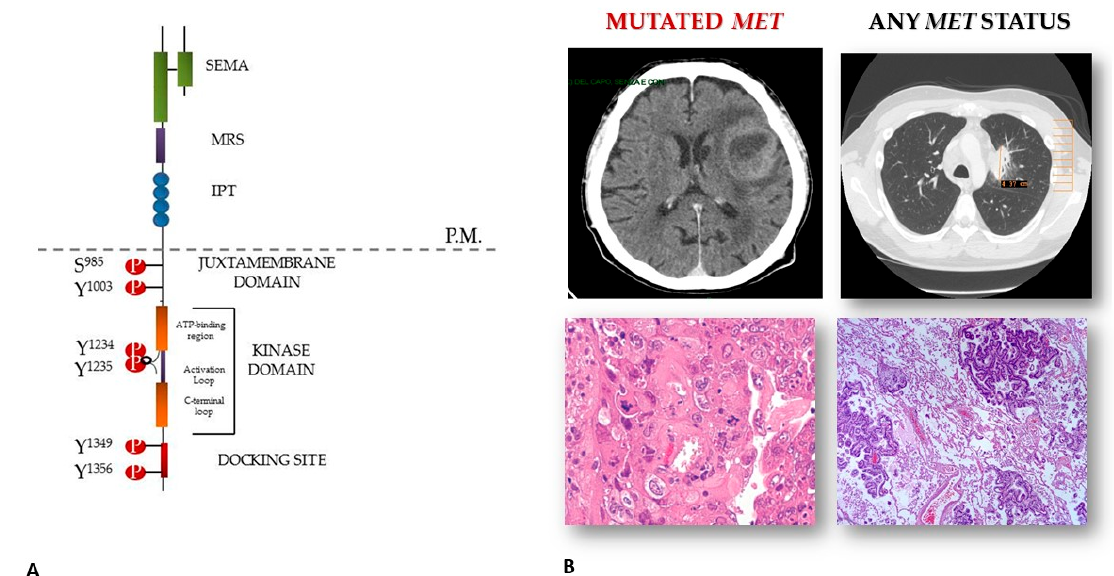
Figure 1. MET activation in brain lesions from non-small cell lung cancer (NSCLC). Panel ( A ) structure of the MET receptor; panel ( B ) brain metastases and the matched primary lung mass. The lesions feature similar histo-morphology, but different MET status, with MET mutated cells being only detected in the secondary lesion.